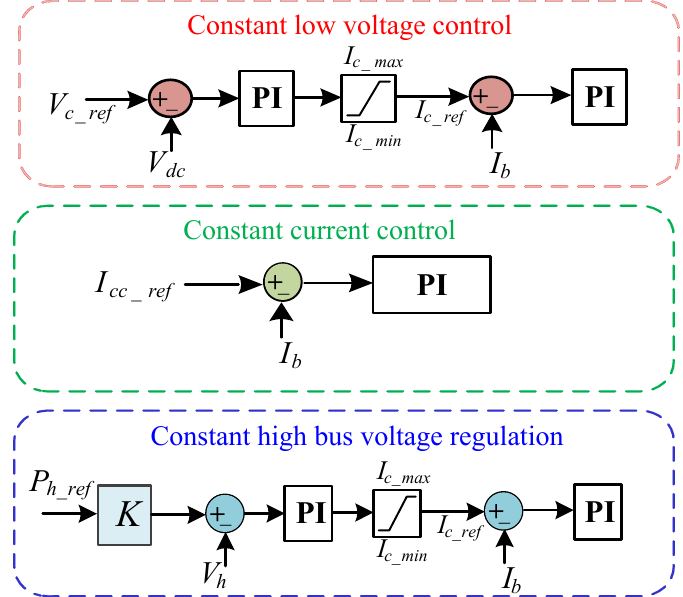
Figure 2. Different control modes of ESU.